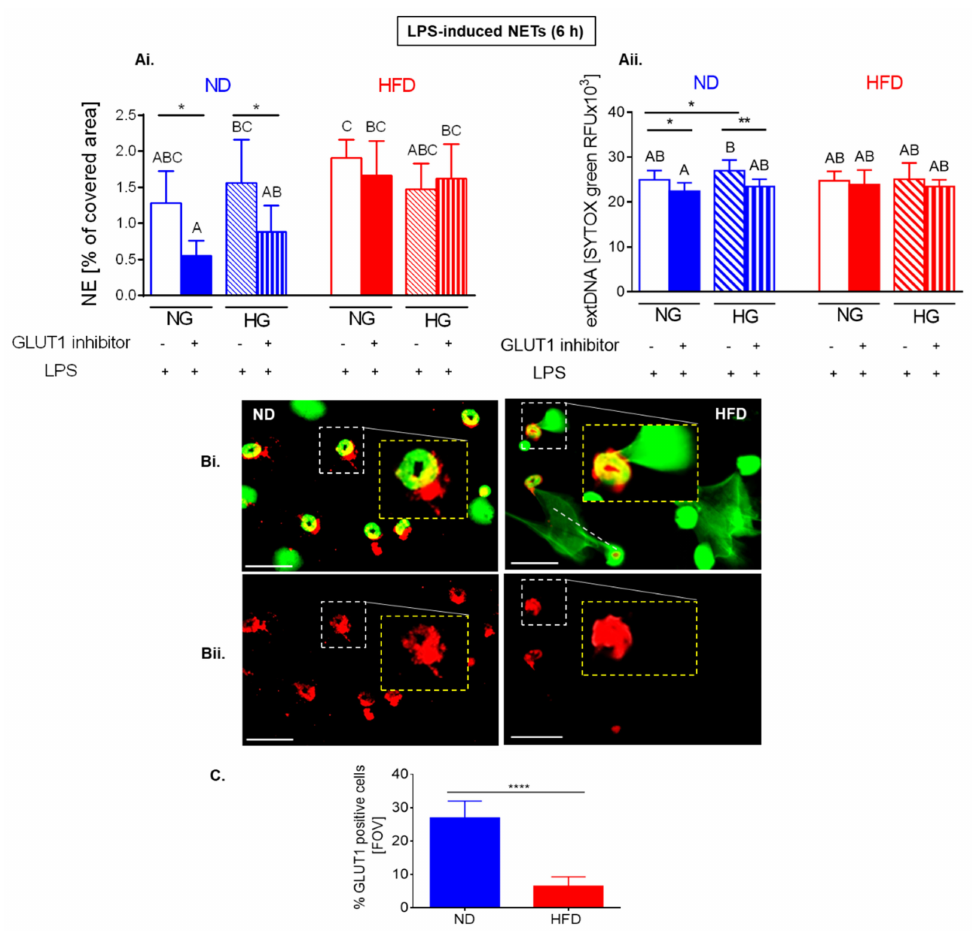
Figure 8. GLUT1-dependent long-term LPS-induced formation of neutrophil extracellular traps (NETs) by neutrophils of mice with obesity induced by high fat diet (HFD) and their lean controls (ND). Neutrophils were collected from healthy mice, and prior to ex vivo studies in which they were stimulated with lipopolysaccharide (LPS) for 6 h, they were pretreated with glucose transporter protein 1 (GLUT1) inhibitor. Additionally, some neutrophils were cultured in HBSS supplemented with high glucose (22 mM, HG) or normal glucose (5.5 mM, NG). NETs were quantified upon staining of neutrophil elastase (NE, ImageJ software) ( Ai ), and ( Aii ) extracellular DNA (extDNA) with SYTOX green; fluorescent signal was quantified using a microplate reader (relative fluorescence units, RFU). ( B ) Expression of GLUT1 (red) was estimated in LPS-stimulated neutrophils by immunocytochemistry and is expressed as a percentage of GLUT1-positive cells per field of view (FOV; C ). In ( Bi ), yellow dashed line denotes exemplary cells enlarged by 250% (original location of the cells is marked with a white dashed line). In ( Bii ), only GLUT1-positive signal is shown (red). Scale bar indicates 25 µ m (( B )—representative images, ( C )—data quantification). Asterisks indicate significant differences between groups upon unpaired two-tailed Student’s t -test (* p ≤ 0.05, ** p ≤ 0.01). Results of one-way ANOVA (post hoc Bonferroni): any two means that do not share same letter are significantly different. Data are shown as mean ± s.d.; n ≥ 3 per